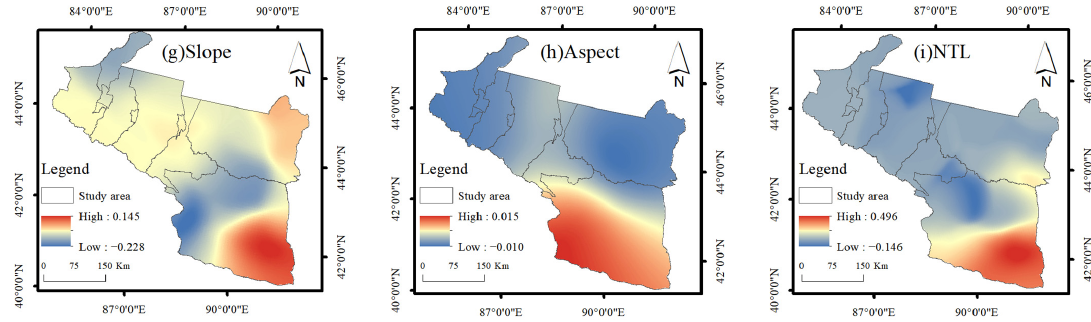
Figure 8. Spatial distribution of regression coefficients of LST influence factor patterns.